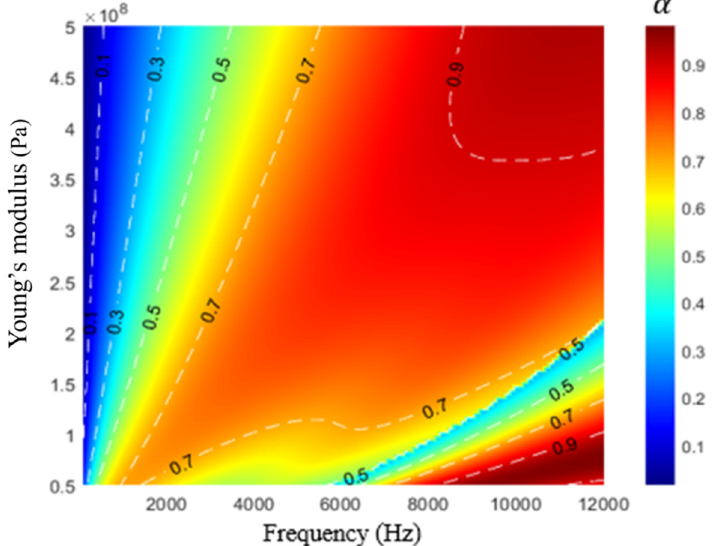
Figure 15. Influence of the real part of Young’s modulus on sound absorption.